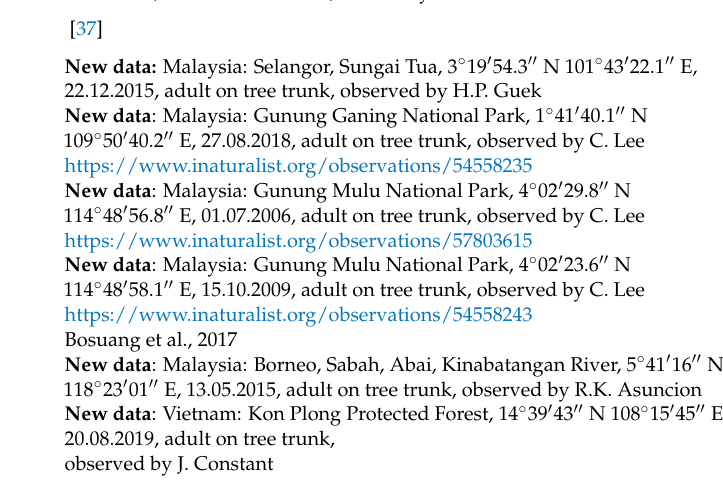
Figure 16c Pyrops candelaria (Linn é , 1758) Figure 16d Pyrops candelaria (Linn é , 1758) Figure 16e Pyrops coelestinus (Stål, 1863) Figure 17a Pyrops connectens (Atkinson, 1885)